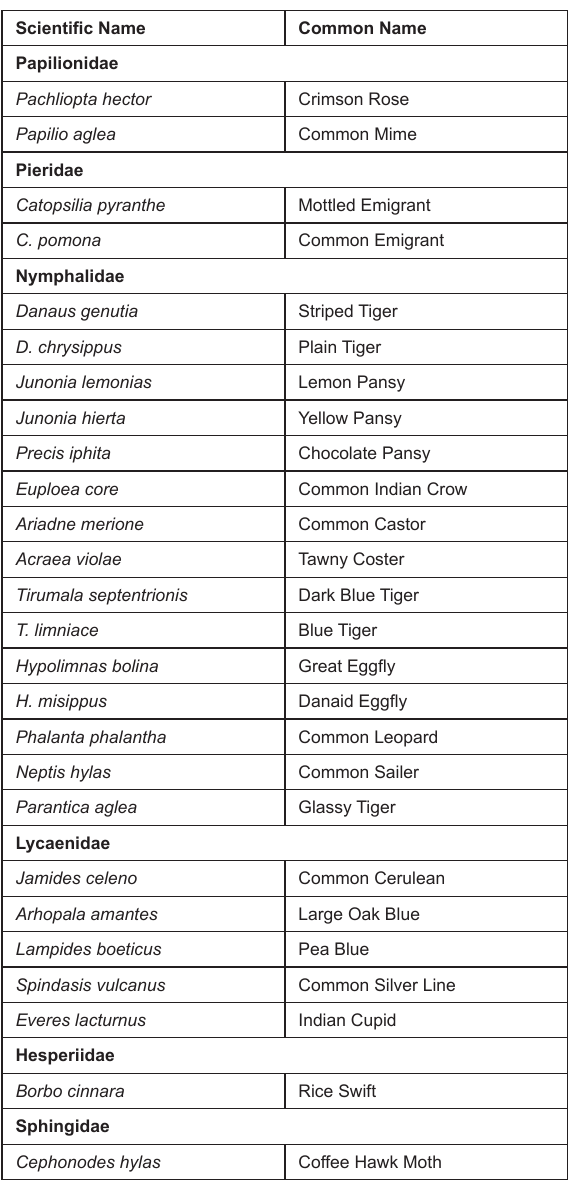
Table 1. List of nectar feeding butterflies on Wendlandia tinctoria